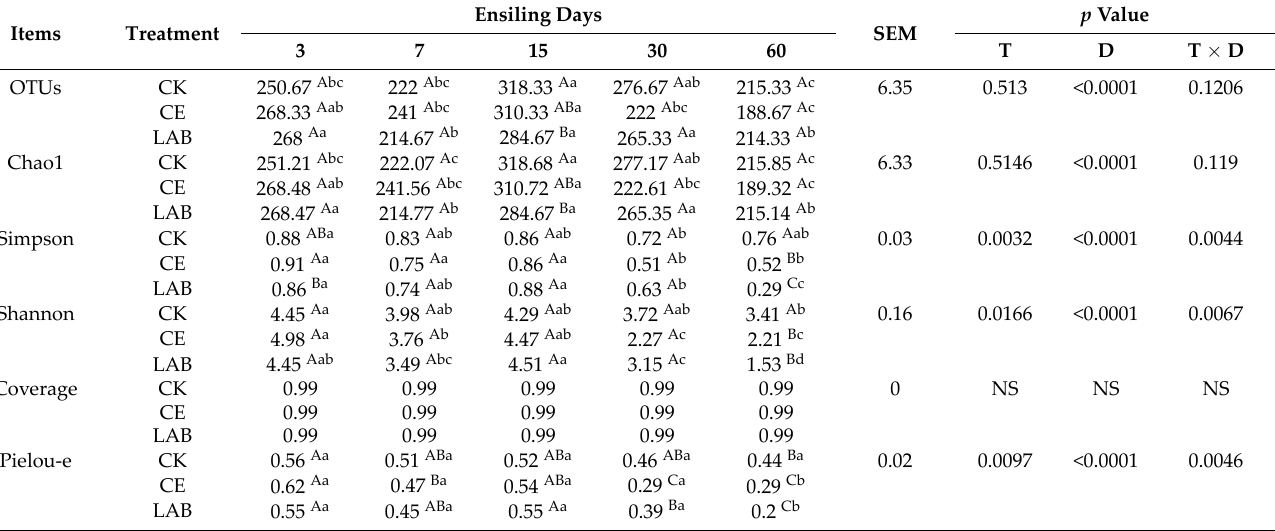
Table 4. Effects of additives and ensiling days on bacterial alpha diversity of Caragana korshinskii